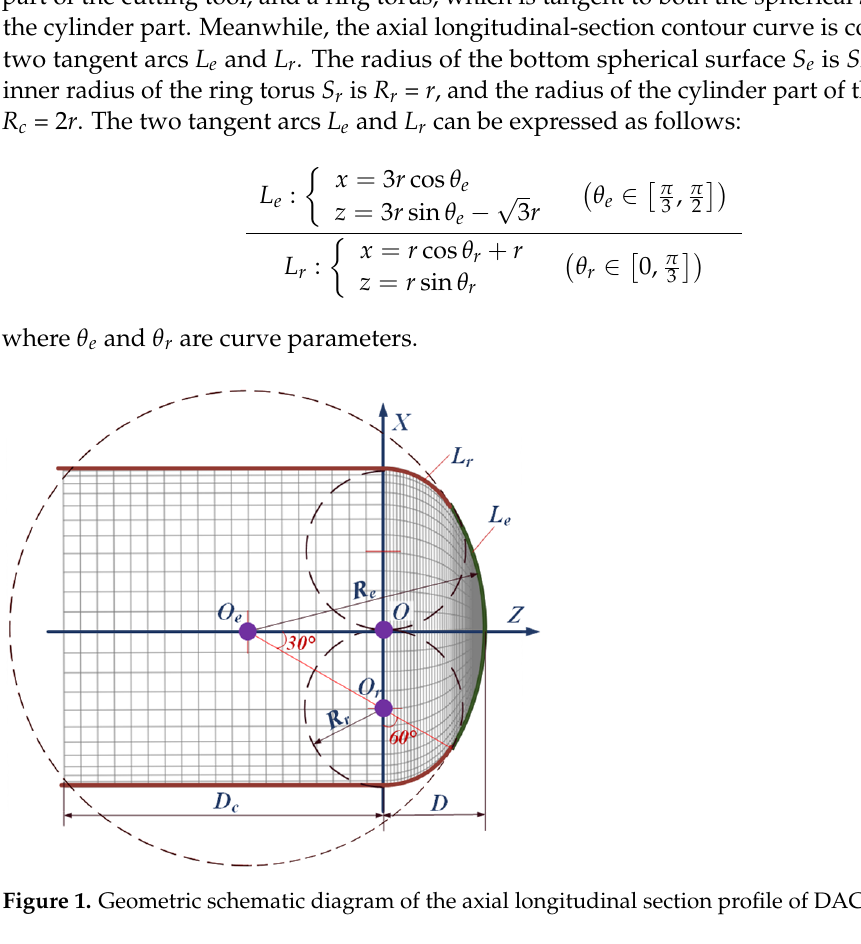
where ϕ e and ϕ r are surface